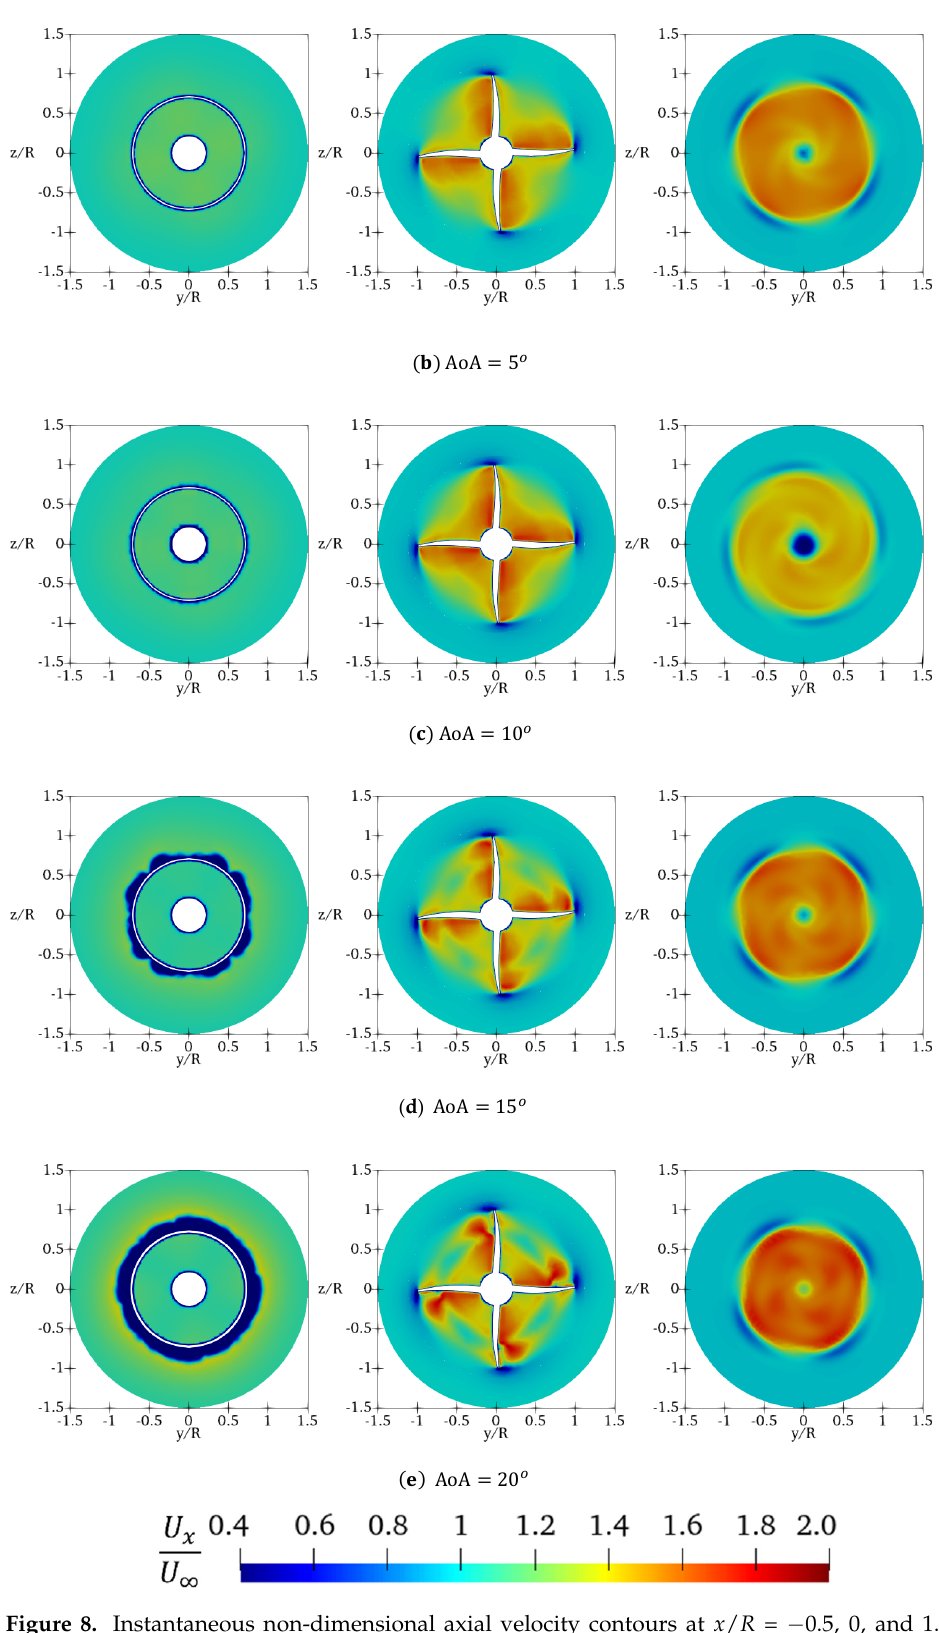
Figure 8. Instantaneous non-dimensional axial velocity contours at x / R = − 0.5, 0, and 1.5 for D D = 0.7 D P (left: x / R = − 0.5; middle: x / R = 0; right: x / R = 1.5 ).